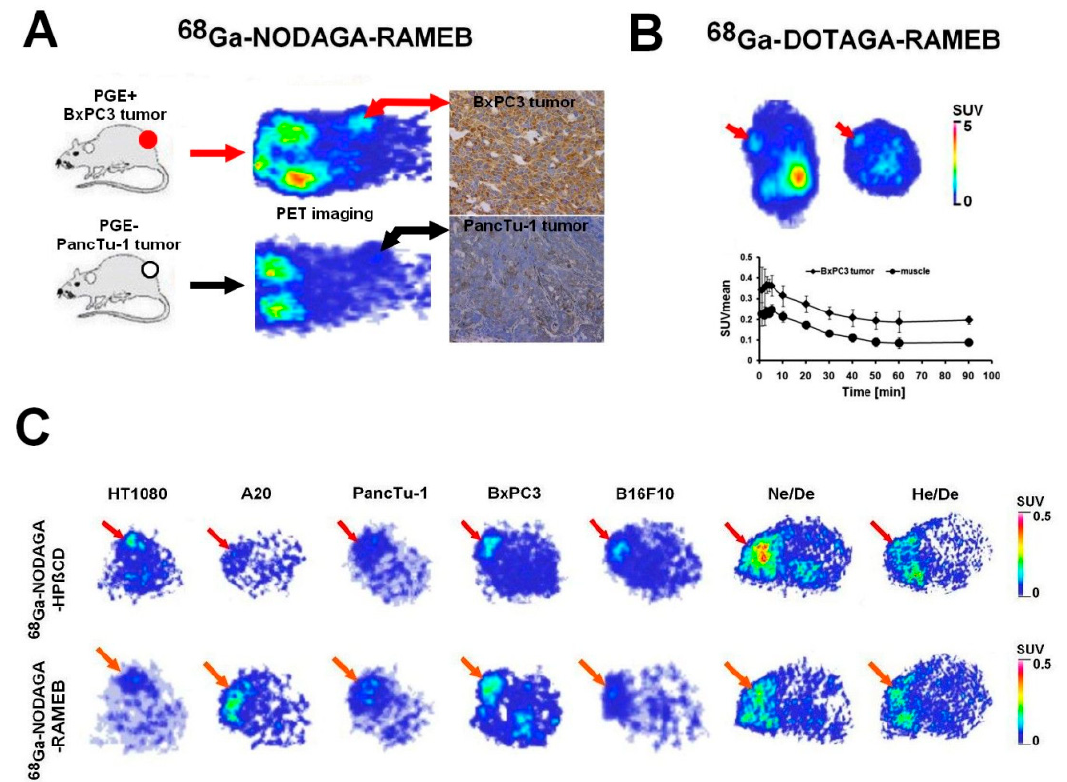
Figure 3. In vivo PET imaging of experimental tumors using 68 Ga-labelled CDs. ( A ) panel: In vivo assessment of [ 68 Ga]Ga-NODAGA-RAMEB accumulation in PGE2 positive (BxPC3) and negative (PancTu-1) human pancreas adenocarcinoma tumors using miniPET imaging 90 min after the intra- venous injection of [ 68 Ga]Ga-NODAGA-RAMEB. Decay-corrected PET images were obtained 12 ± 1 days after subcutaneous cancer cell inoculation. Red arrows: BxPC3 tumors; black arrows: PancTu- 1 tumors. From [43] with permission. The microscope magnification was 40×. ( B ) panel: In vivo ac- cumulation of the intravenously injected [ 68 Ga]Ga-DOTAGA-RAMEB in BxPC-3 tumor in SCID mice. Representative decay-corrected static coronal (left) and transaxial (right) PET images 90 min after radiotracer injection. Time-activity curve of [ 68 Ga]Ga-DOTAGA-RAMEB in BxPC-3 tumor and muscle (background). Red arrows: subcutaneously growing BxPC-3 tumor. From [47] with permis- sion. ( C ) panel: Representative decay-corrected transaxial PET images of experimental tu- mors after the intravenous injection of [ 68 Ga]Ga- NODAGA-HP B CD /HP β CD (red arrows), [ 68 Ga]Ga- NODAGA-RAMEB (orange arrows). Decay-corrected PET images were obtained 10 ± 2 days after subcutaneous tumor cell injection and 9 0 min after the intravenous injec- tion of the 68 Ga-labelled CDs. From [35] with permission. A20: mouse B cell lymphoma; BxPC-3: human pancreas adenocarcinoma; B16-F10: mouse melanoma; CD: cyclodextrin; DOTAGA: 1,4,7,10-tetrakis(carboxymethyl)-1,4,7,10-tetraazacyclododecane glutaric acid; 68 Ga: Gallium-68; He/De: rat hepatocellular carcinoma; HPBCD/HP β CD: hydroxypropyl- β -cyclodextrin; HT1080: hu- man fibrosarcoma; Ne/De: rat mesoblastic nephroma; NODAGA: 1,4,7-triazacyclononane-1-glutaric acid-4,7-diacetic acid; PancTu-1: pancreas ductal epitheloid carcinoma; PET: positron emission to- mography; PGE2: prostaglandin E2; SCID: severe combined immunodeficient; SUV: standardized uptake value; RAMEB: randomly methylated beta-cyclodextrin.